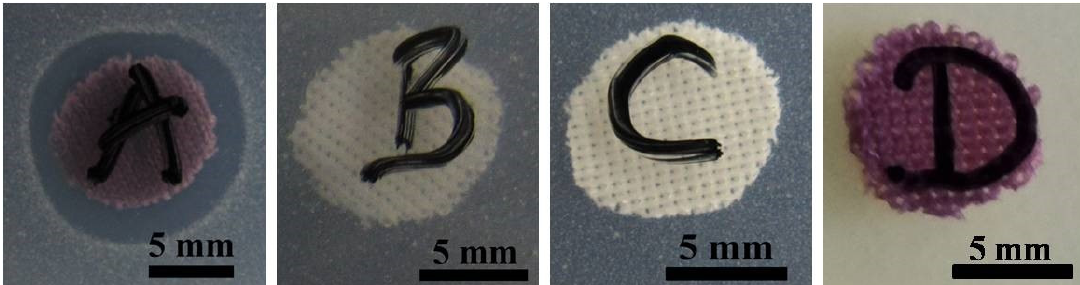
Figure 4. Images of bacteriostatic properties of the PA surface ( a ) modified with tethered gold nanoparticles Au (NPs) @PA- g -[(PMMA 164 -H)- mixed brushes -PDMAEMA 63 -Br], ( b ) unmodified PA, ( c ) modified with tethered PA- g -[(PMMA 164 -H)- mixed brushes -PDMAEMA 63 -Br], and ( d ) PA with soaked Au NPs.